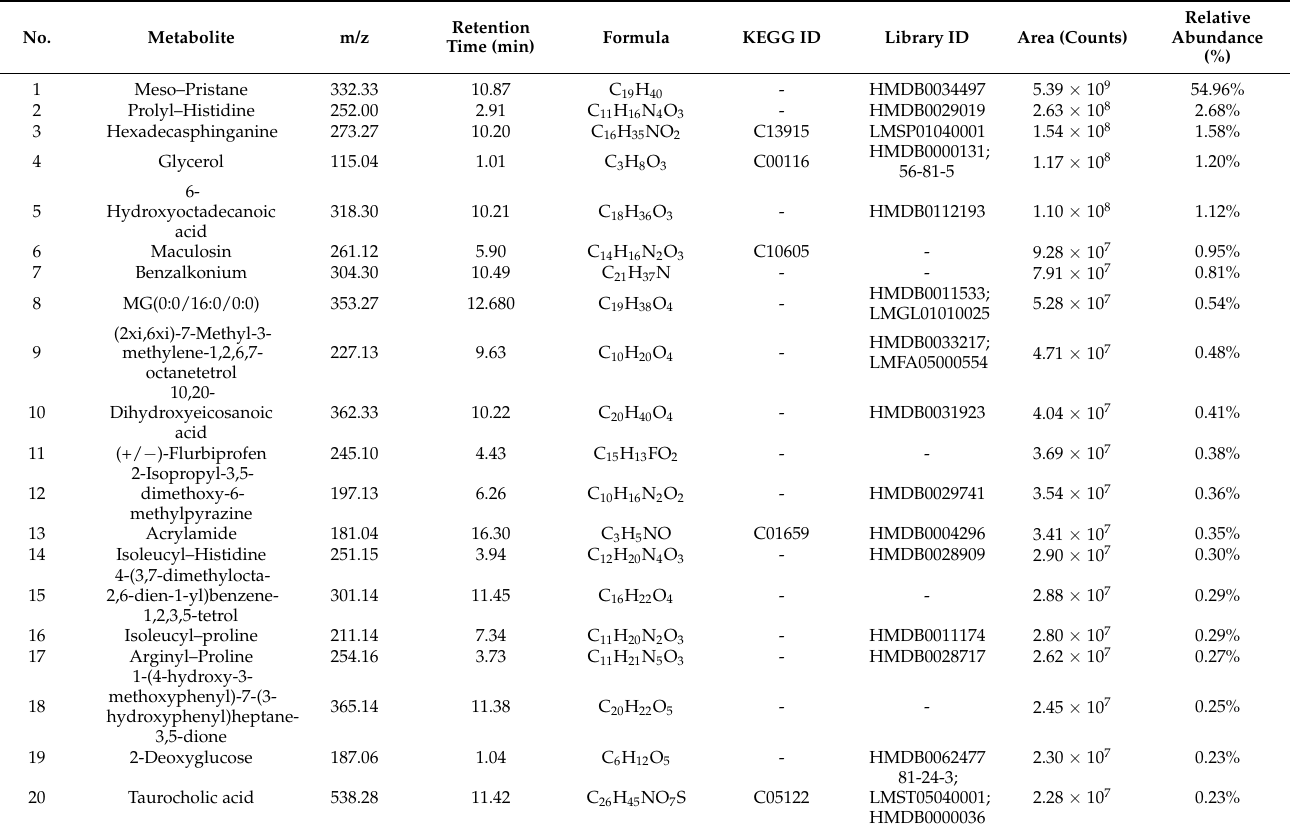
Table 1. The metabolites of the low molecular weight fermentation products of A. macleodii QZ9-9 with the relative abundances of the top 20.